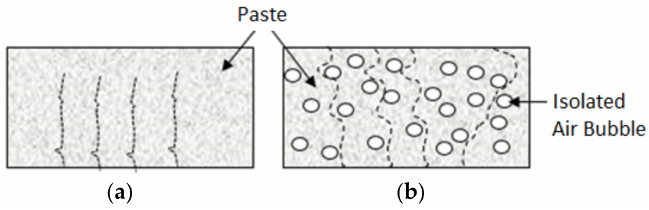
Figure 11. Sorption paths into non-aerated and aerated slurries. ( a ) Non-aerated; ( b )